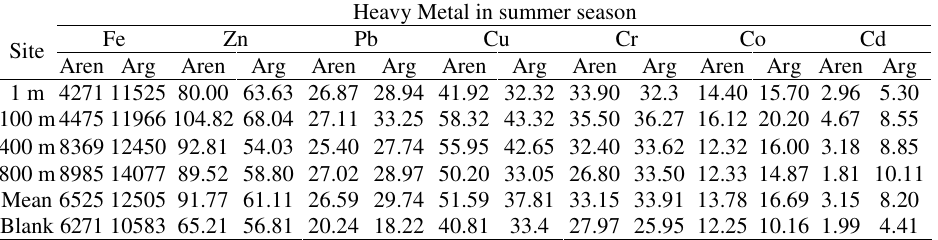
Table 7. Average heavy metal concentrations in ppm from different fractions of sediments in summer season along stream Flow in the investigated area in addition to blank